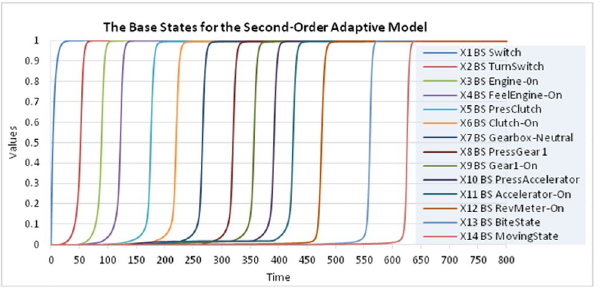
Fig 4. Dynamics of the base states X 1 -X 14 showing internal simulation of the mental model.